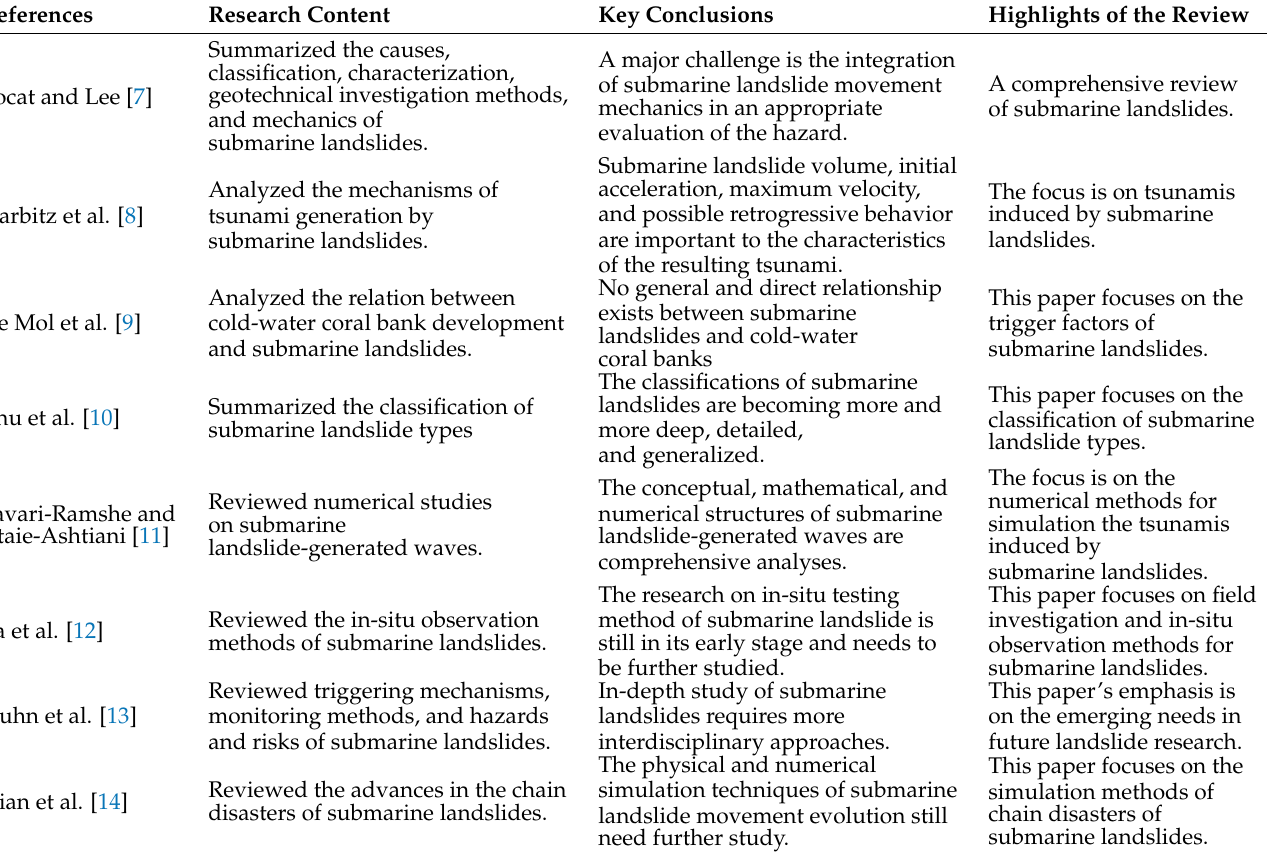
Table 1. Summary of existing reviews regarding submarine landslides in recent